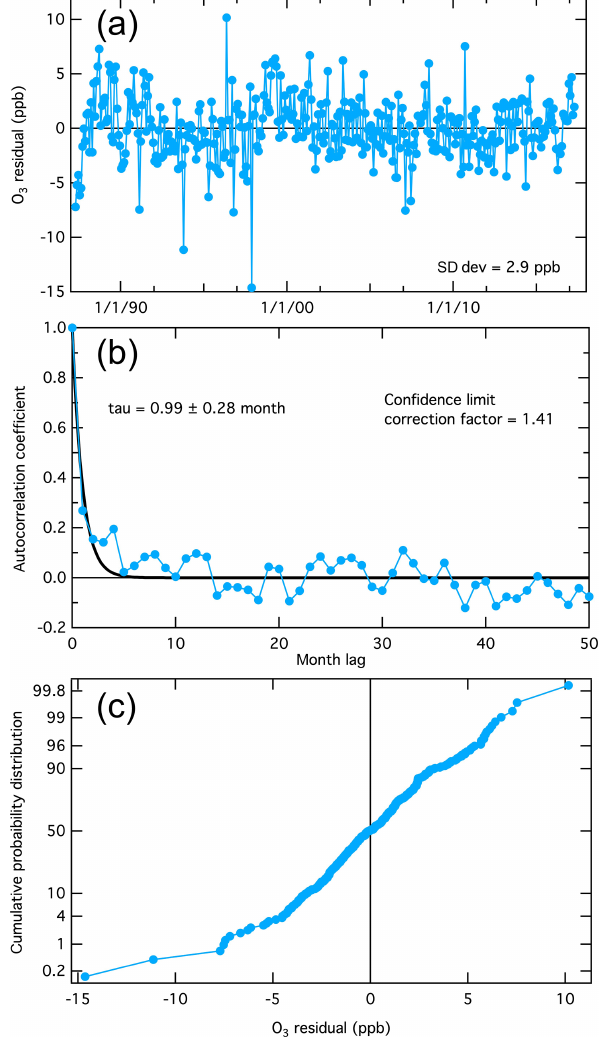
Figure 6. Analysis of the deviations between the monthly mean baseline ozone concentrations and the fit of Eq. (4) to these means (i.e., the fit residuals) illustrated in Fig. 4. (a) Time series of the residuals. (b) The time lag autocorrelation of the residuals. The fit- ted curve is an exponential decrease from unity at a lag of zero months, with the time constant, tau, annotated. (c) Cumulative prob- ability distribution of the residuals, plotted on an ordinate scale that gives a linear fit for a Gaussian